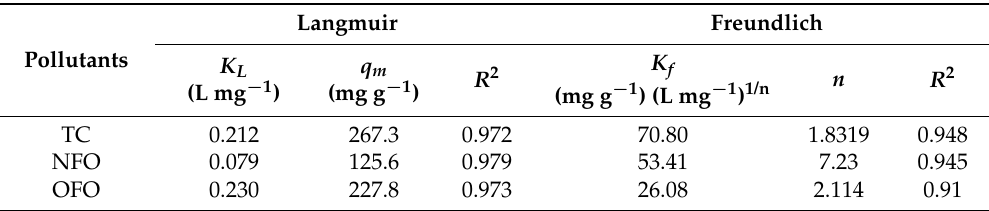
Table 1. The relevant fitting parameters of tetracycline (TC), norfloxacin (NFO), and levofloxacin (OFO) simulated using Langmuir and Freundlich models.